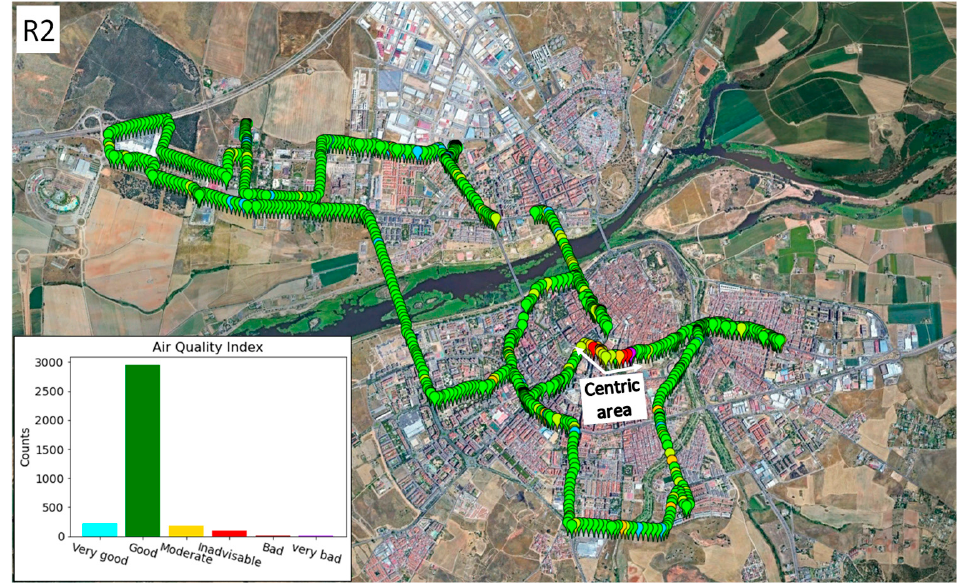
Figure 12. Route 2, Badajoz (Spain), on 24 January